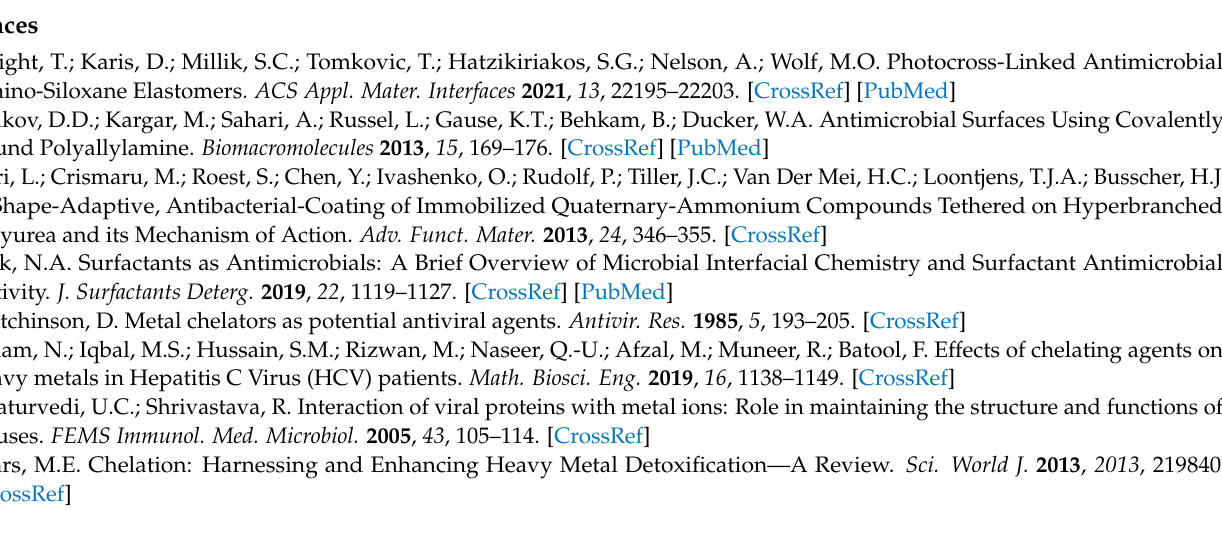
CDCl 3 . Figure S3. (A) 1 H-NMR and (B) 29 Si-NMR for 3-Vi in CDCl 3 . Figure S4. (A) 1 H-NMR and (B) 29 Si-NMR for 4-Vi in CDCl 3 . Figure S5. 1 H-NMR for 7-6OEt in CDCl 3 . Figure S6. (A) 1 H-NMR and (B) 29 Si-NMR for 19-6OEt in CDCl 3 . Figure S7. (A) 1 H-NMR and (B) 29 Si-NMR for 62-6OEt in CDCl 3 . Figure S8. (A) 1 H-NMR and (B) 29 Si-NMR for 9OEt in CDCl 3 . Figure S9. (A) 1 H-NMR and (B) 29 Si-NMR for 12OEt in CDCl 3 . Figure S10. (A) 1 H-NMR and (B) 29 Si-NMR for 7-6Vi in CDCl 3 . Figure S11. (A) 1 H-NMR and (B) 29 Si-NMR for 19-6OVi in CDCl 3 . Figure S12. (A) 1 H- NMR and (B) 29 Si-NMR for 62-6Vi in CDCl 3 . Figure S13. (A) 1 H-NMR and (B) 29 Si-NMR for 9Vi in CDCl 3 . Figure S14. (A) 1 H-NMR and (B) 29 Si-NMR for 12Vi in CDCl 3 . Figure S15. (A) 1 H-NMR and (B) 29 Si-NMR for N 7-6 in CDCl 3 . Figure S16. 1 H-NMR for N 19-6 in CDCl 3 . Figure S17. 1 H-NMR for N 62-6 in CDCl 3 . Figure S18. (A) 1 H-NMR and (B) 29 Si-NMR for N9 in CDCl 3 . Figure S19. (A) 1 H-NMR and (B) 29 Si-NMR for N12 in CDCl 3 . Figure S20. (A) 1 H-NMR and (B) 29 Si-NMR for HO7-6 in MeOH- d 4 . Figure S21. 1 H-NMR for HO62-6 in MeOH- d 4 . Figure S22. (A) 1 H-NMR and (B) 29 Si-NMR for HO9 in MeOH- d 4 . Figure S23. (A) 1 H-NMR and (B) 29 Si-NMR for HO12 in MeOH- d 4 . Figure S24. 13 C-NMR for a) 3-Vi, b) 9OEt, c) 9-Vi, d) N9 in CDCl 3 and e) HO9 in MeOH -d4 . Figure S25. Titration by copper (II) of (A) N12. (B) N6. Figure S26. Job Plots of (A) N12. (B) N6. Figure S27. Adsorption of Cu 2+ into a thin film of HO62-6 coated on a silicone elastomer